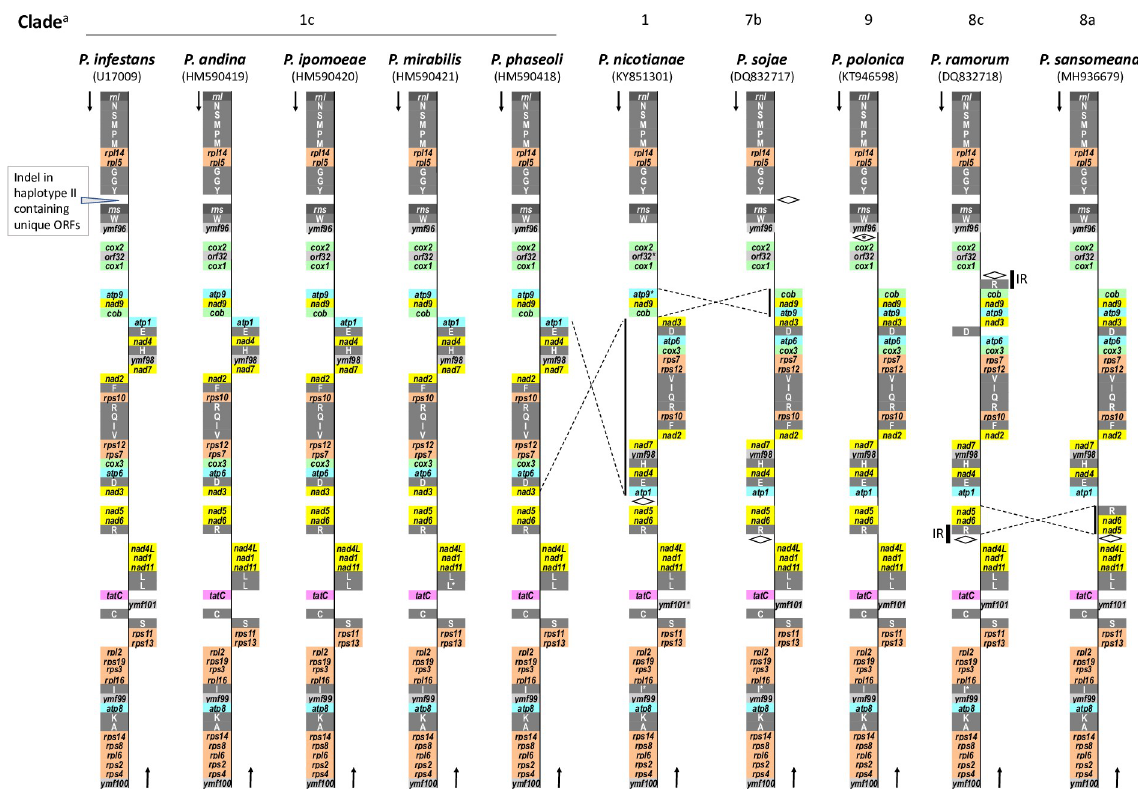
Fig 2. Linear representation of gene contents and organization of mitochondrial genomes of 10 Phytophthora species. RNA genes are in white letters with rRNA genes in dark grey background and tRNA genes in grey background. Protein coding genes are in dark letters with the following backgrounds: cytochrome C reductase and oxidases, green; ATP synthases, blue; NADH dehydrogenases, yellow; ribosomal protein genes, brown; twin-arginine translocase, purple; and conserved ORFs with unknown function, light grey. The diamond symbols represent regions with one or more ORFs unique to that particular species. In species other than P . sansomeana , protein coding genes with an asterisk are those identified in this study not presented in GenBank annotations. tRNA genes with an asterisk are those whose annotations are modified in this study, either in coding strand or in identity, comparing to GenBank annotations. tatC gene was previously given the gene symbol ymf16 ( ymf is used to designated conserved ORF in mitochondria without annotated function) or SecY in species other than P . sansomeana . Our analysis showed that it should be named tatC (see text for detail). IR, inverted repeat. a Clade designation is based on [11, 12].